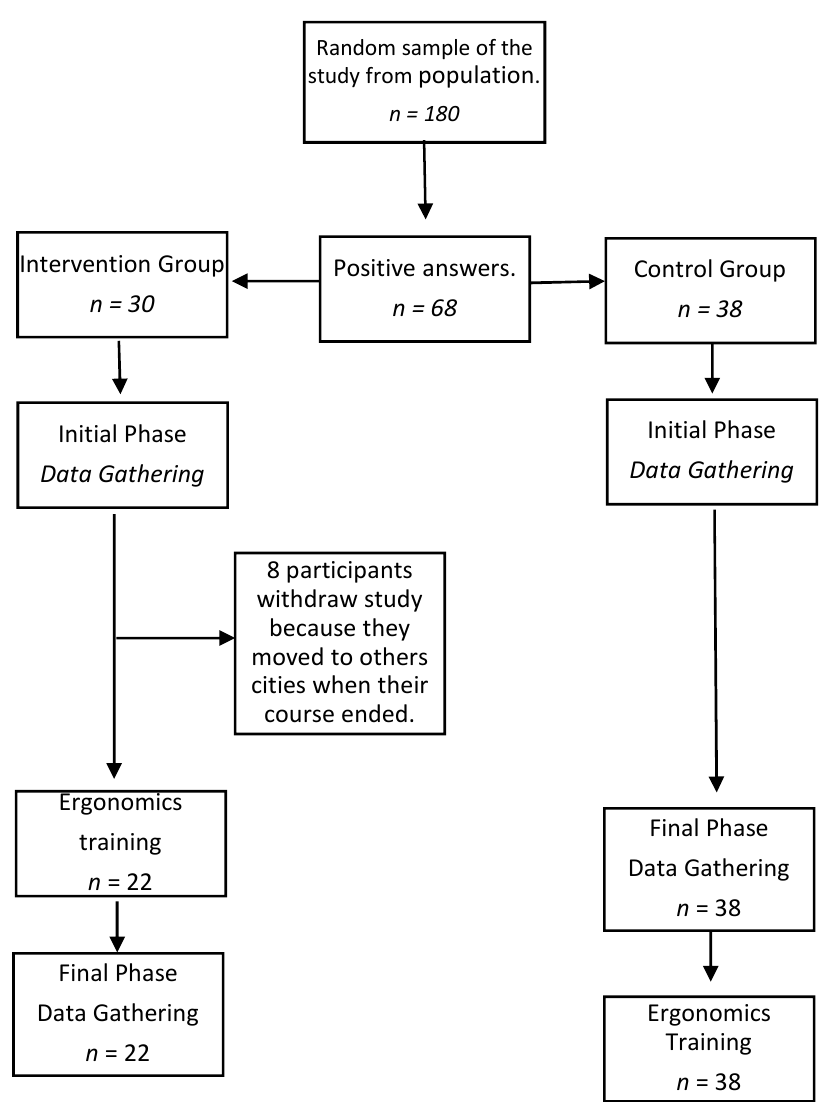
Figure 1. Flow chart of participants enrolled in the study and the logistics regarding the two groups.